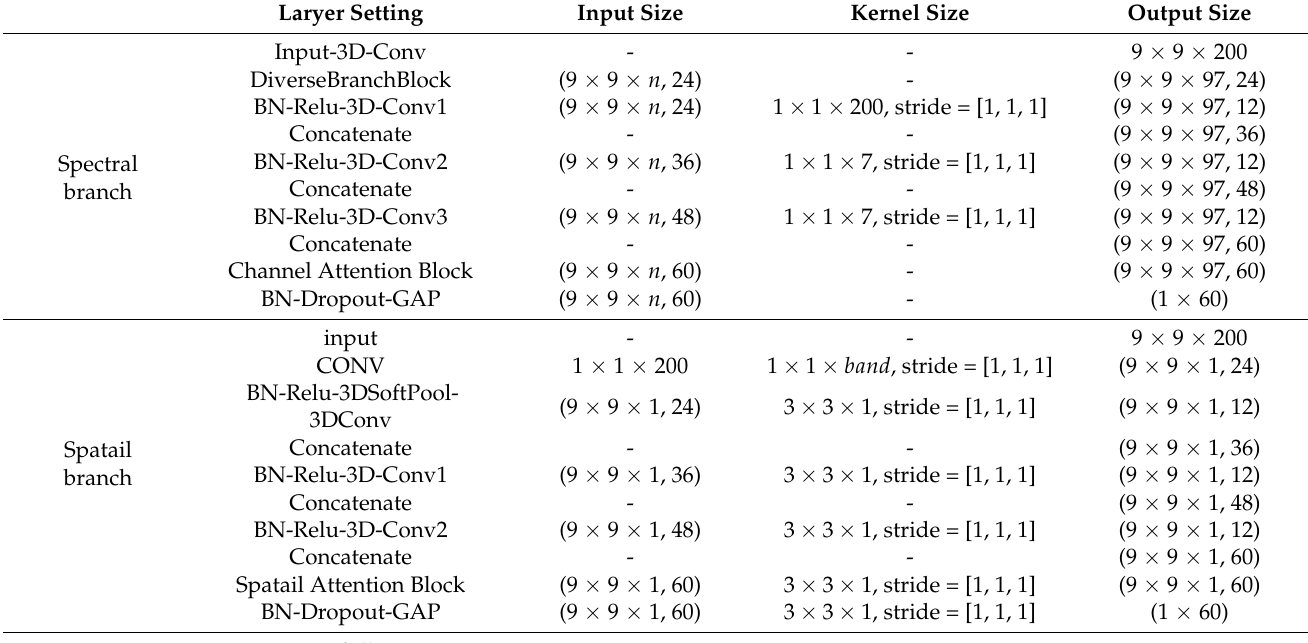
Table 5. Experimental parameters and